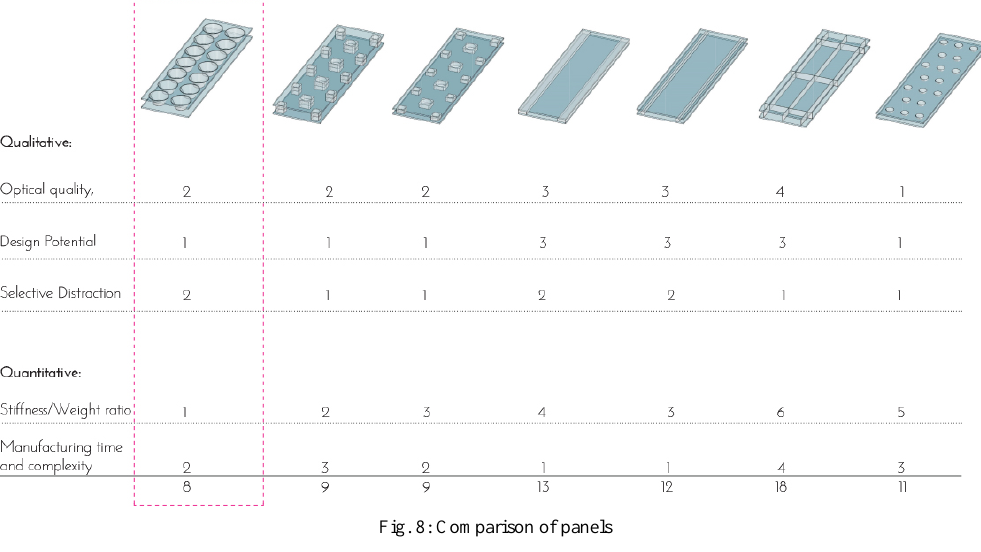
Fig. 8: Comparison of